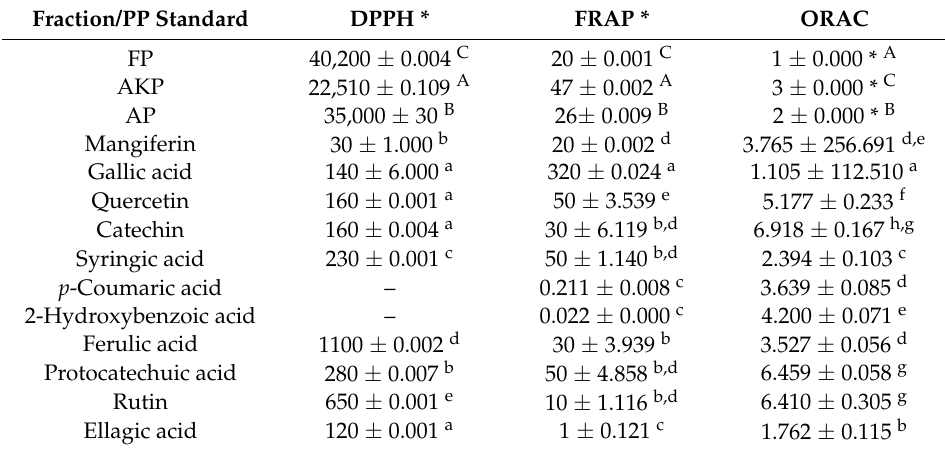
Table 2. Antioxidant activity of and ‘Ataulfo’ mango peel polyphenol extract’s fractions and individual